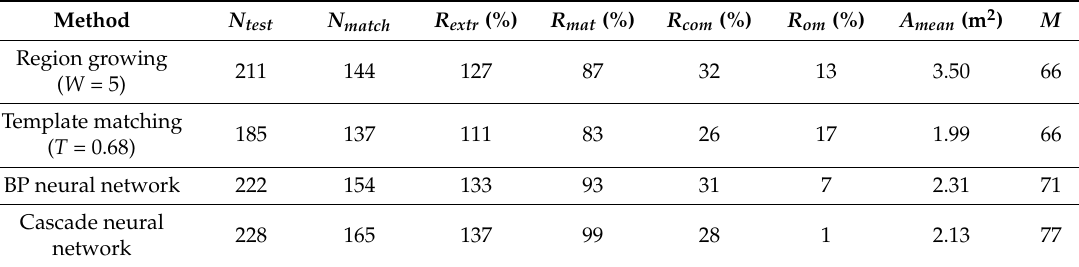
Table 4. Detection results for test area 4.